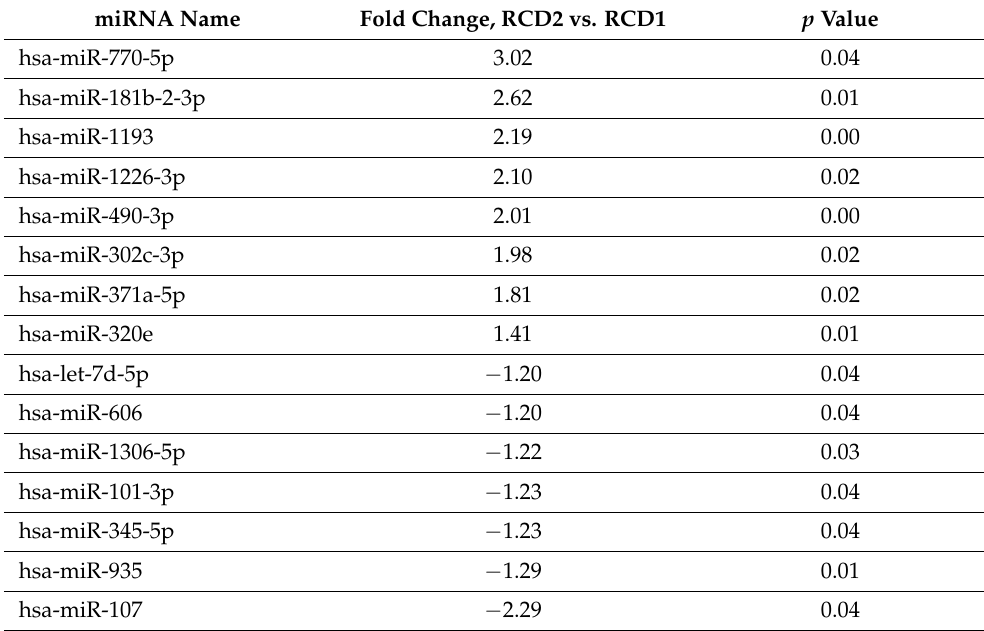
Figure 1. An expression heatmap of deregulated miRNAs in unresponsive patients vs. patients responsive to a GFD. The upregulated miRNAs are indicated in Red, and the downregulated miRNAs are indicated in Green. p value < 0.05, and FDR and Bonferroni correction < 0.05. Table 1. The dysregulated miRNAs evaluated in serum samples obtained from RCD2 and RCD1 patients. miRNA